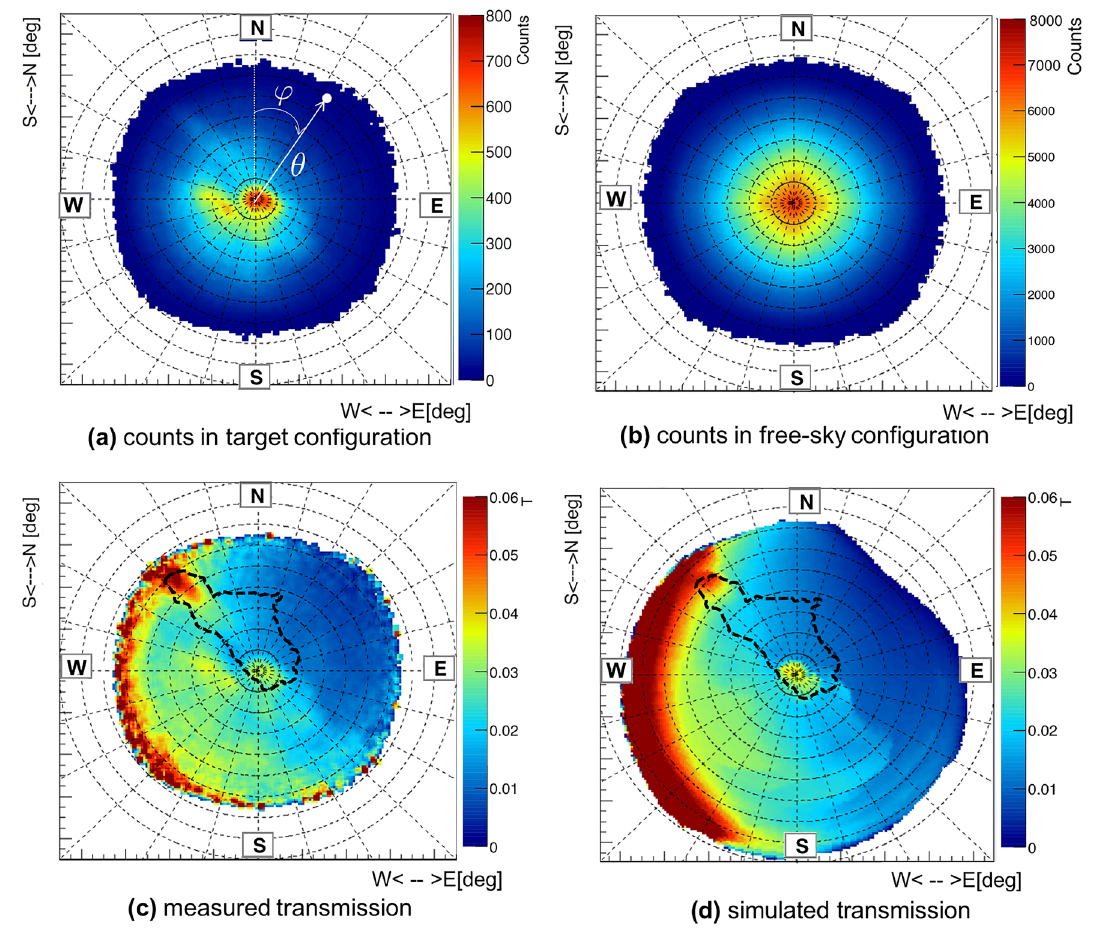
Figure 4. ( a ) the angular distribution of muon counts obtained from installation 1 in the mine ( target configuration ); ( b ) the distribution of the counts obtained in the free-sky configuration . ( c ) the measured muon transmission and ( d ) simulated transmission for a homogeneous target density of 2.65g / cm 3 . In ( c ) and ( d ) the profile of the Gran Cava is shown as a dashed line. ( ϕ ). The acceptance in the simulation ( d ) is larger than that of the detector shown in the other subfigures. The figures show a grid: the circles every 10 degrees represent the zenith angles ( θ ), the lines every 15 degrees represent the azimuth angles. The images are obtained with the ROOT 22